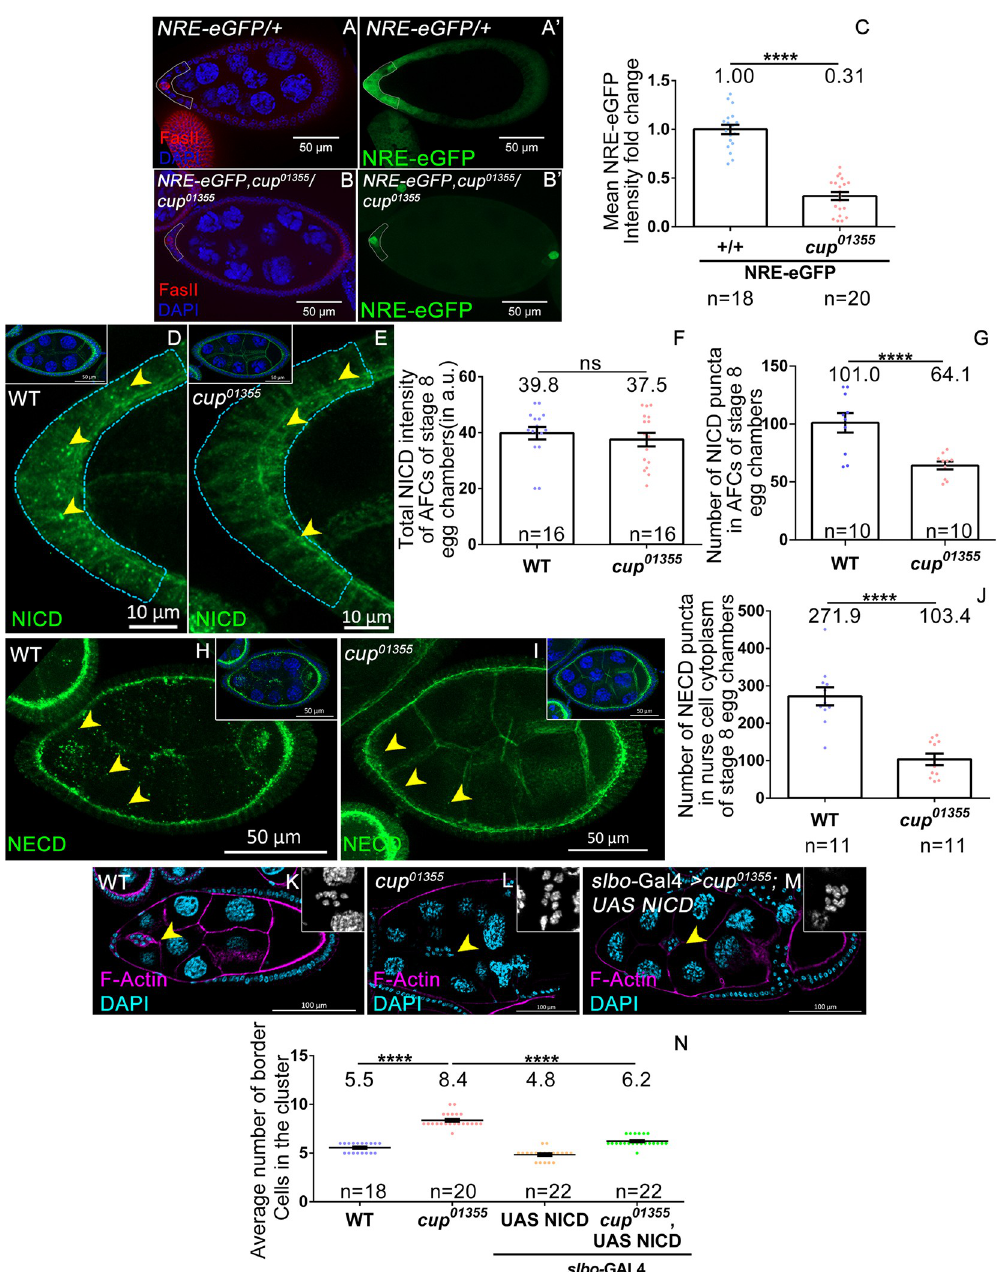
Fig 3. Lower Notch activation in the follicle cells is responsible for the excessive border cell fate observed in the Cup mutants. (A-C) Intensity of NRE-eGFP (in green) is significantly decreased in the anterior follicle cells of stage 8 cup 01355 egg chambers. (A-B) Dotted line marks the anterior follicle cells expressing NRE-eGFP in the indicated genotypes. Depleted FASII (red) staining indicates stage 8 egg chamber. DAPI (blue). (C) Quantification of the NRE-eGFP. p value of < 0.0001 is indicated by ���� , (D-G) Stage 8 egg chambers stained with NICD (green). (D-E) Reduced number of NICD puncta (yellow arrow head) observed in the anterior follicle cells of cup 01355 mutant egg chamber compared to wild type. Inset is the representative egg chambers (F-G) Quantification of NICD intensity (F) and puncta (G). Though mean intensity of NICD is not significantly different between cup 01355 mutant and wild type follicle cells (F), the number of NICD puncta is significantly reduced (G). (H-J) cup 01355 exhibits lesser number of cytoplasmic puncta of NECD (green) (yellow arrow head) in the nurse cell compared to the wild type. (K-N) Increased BC number is rescued by UAS-NICD , driven by slbo- GAL4 in cup 01355 egg chambers, yellow arrow heads mark BC cluster, F-actin (magenta), DAPI (cyan, grey in inset). Student t-test, p value between WT and cup 01355 is < 0.0001 indicated by ���� , p value between cup 01355 and UAS NICD in cup 01355 is < 0.0001 indicated by ���� , p value between WT and UAS NICD in cup 01355 is 0.0004 indicated by ��� . n represents the number of egg chambers evaluated. SEM represent the error